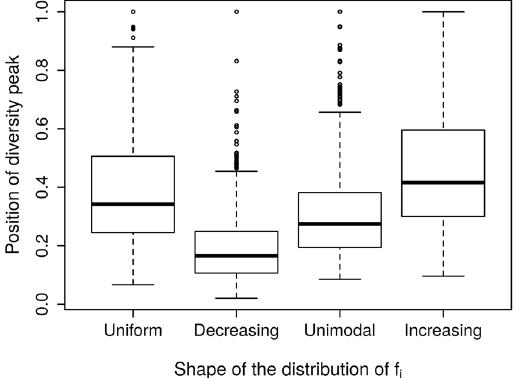
Figure 2. Influence of the shapes of the distribution of f i values on the position of the diversity peak along the biomass gradient across all simulations. A position of 0 indicates that diversity peaks at low level of biomass while a position of 1 indicates that diversity peaks at high level of